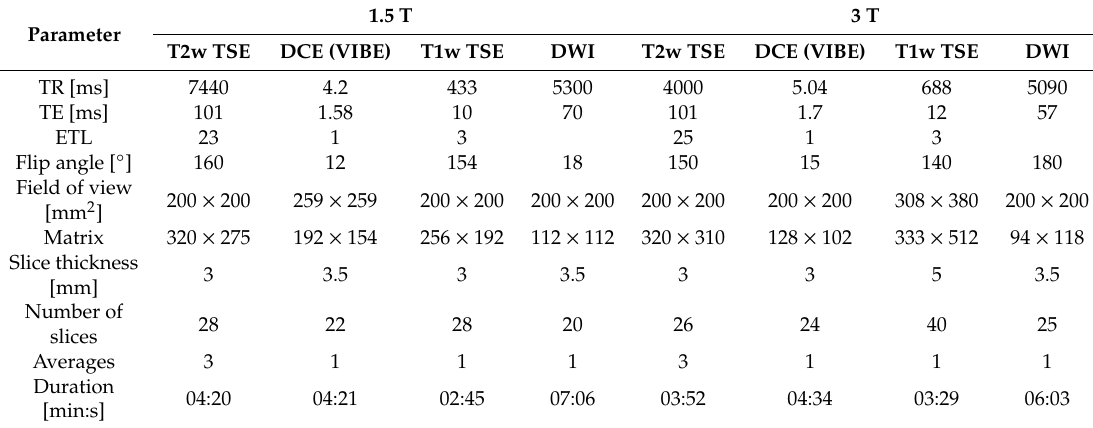
Table 5. MRI acquisition